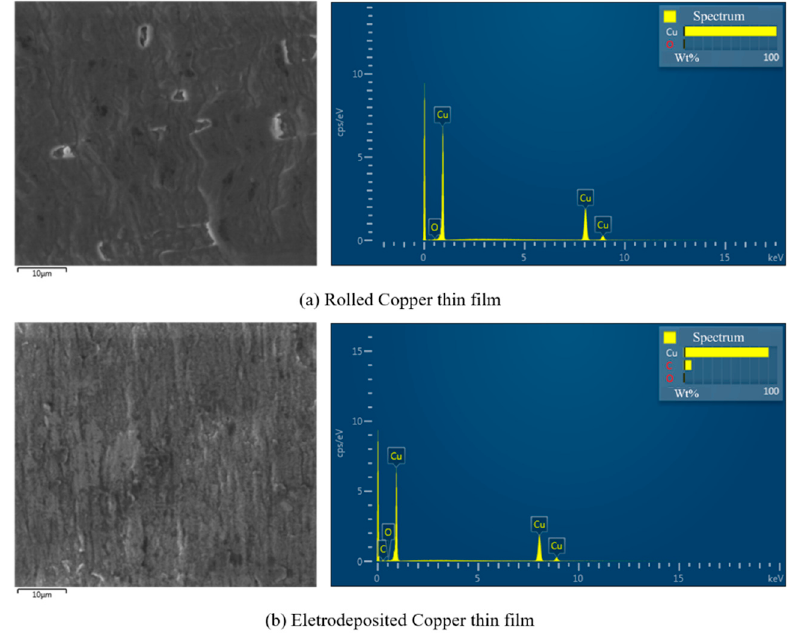
Figure 3. EDS analysis of copper thin film surface. ( a ) Rolled copper thin film ( b ) Electrodeposited copper thin film.